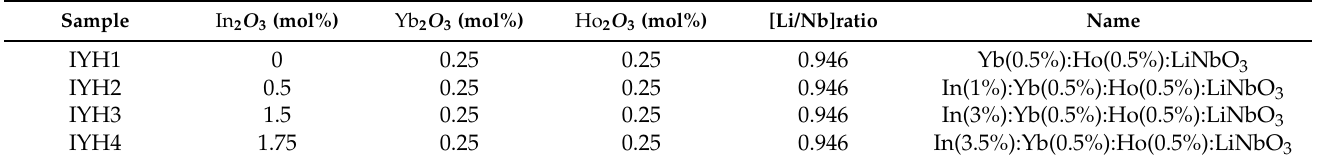
Table 1. Composition of In:Yb:Ho:LiNbO 3